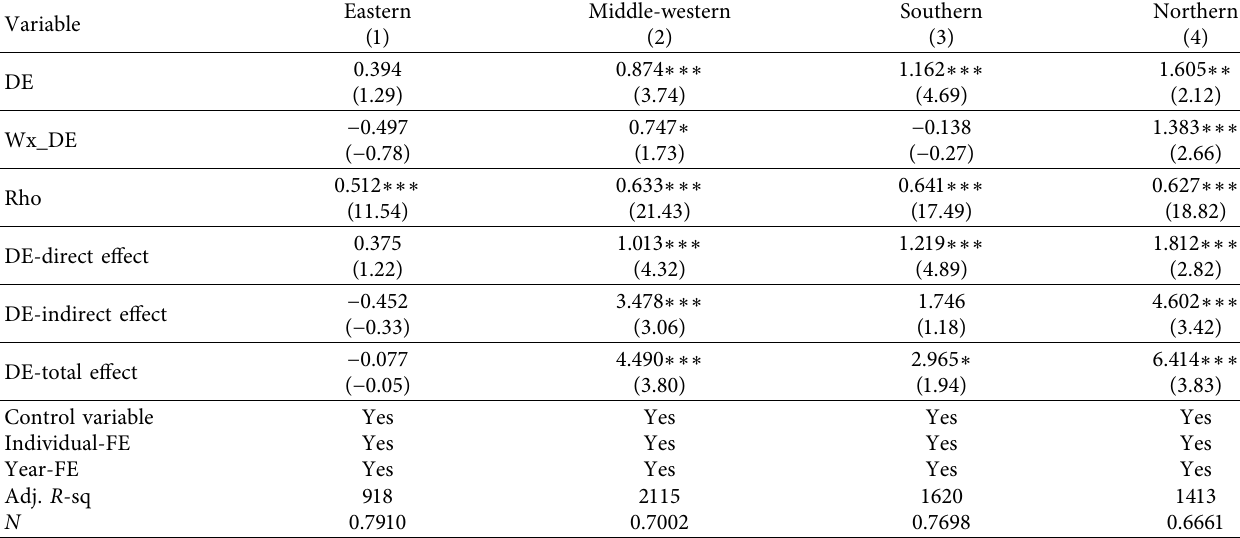
Table 9: Results of analysis of heterogeneity in the impact of the digital economy on urban